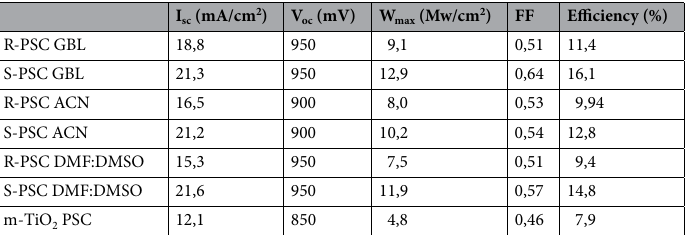
Table 1. IV characteristics of Sep-PSCs and their references based on precursor solvent.